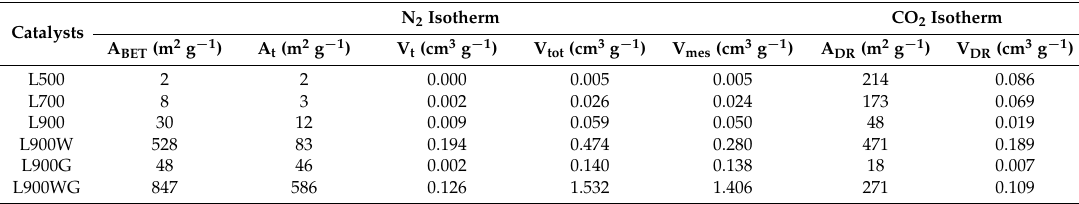
Table 2. Textural parameters obtained from N 2 and CO 2 isotherms at − 196 ◦ C and 0 ◦ C, respectively, of all the carbon catalysts. A BET = apparent surface area; A t = external surface area; V t = micropore volume obtained from the N 2 isotherm; V tot = total pore volume; V mes = mesopore volume; A DR = specific surface area from the CO 2 isotherm; V DR = micropore volume derived from the CO 2